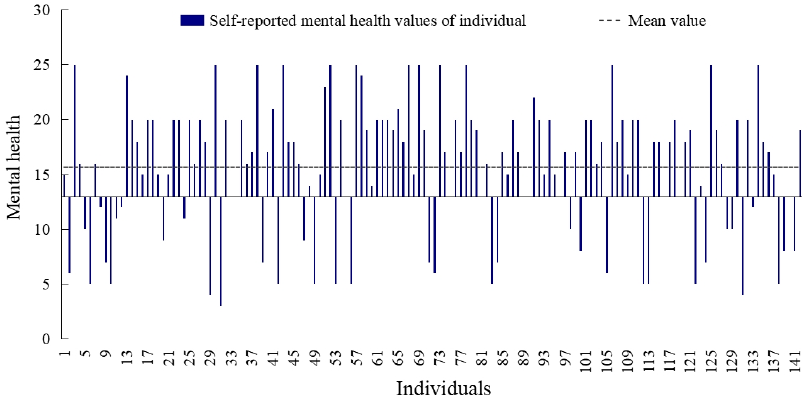
Figure 9. Self-reported mental health values of individual.